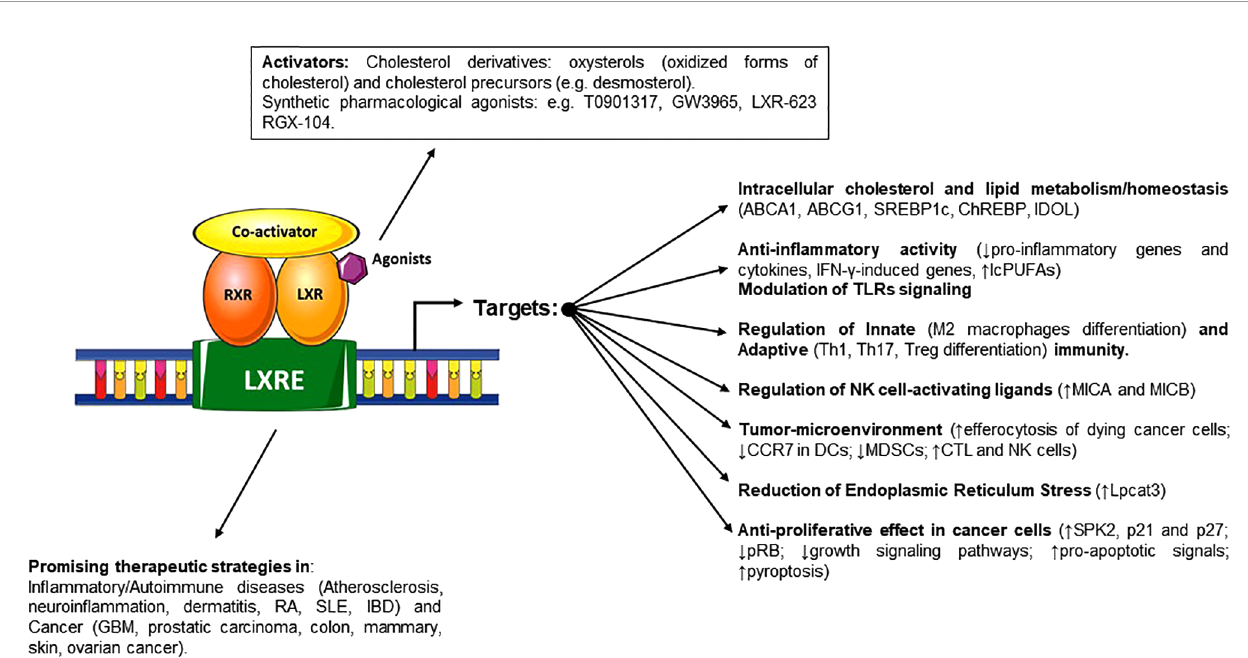
FIGURE 1 | Schematic representation of LXRs activators and the different effects on regulated genes and pathways involved in cholesterol and lipid homeostasis, regulation of immune system and cancer proliferation and progression. When these ligands trigger the activation of LXRs, they heterodimerize with RXR and bind to target gene promoters on LXR-responsive-elements, regulating the transcription and expression of speci fi c target